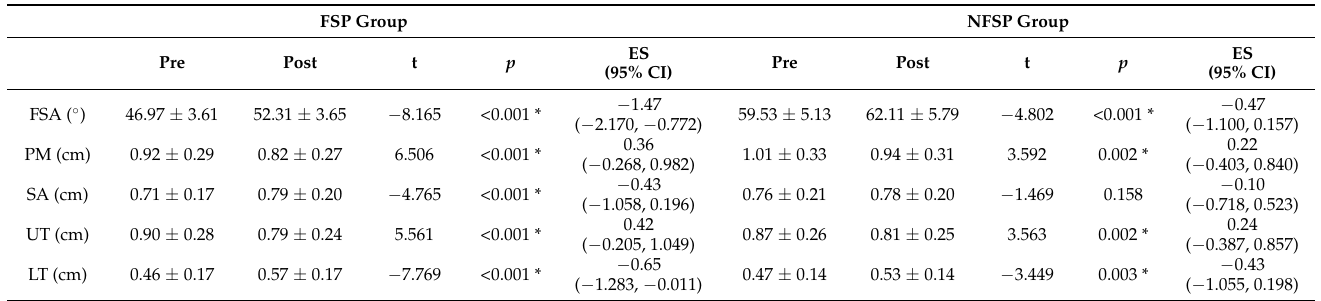
Table 2. Comparison of forward shoulder angle and muscle thickness before and after reverse plank exercise.